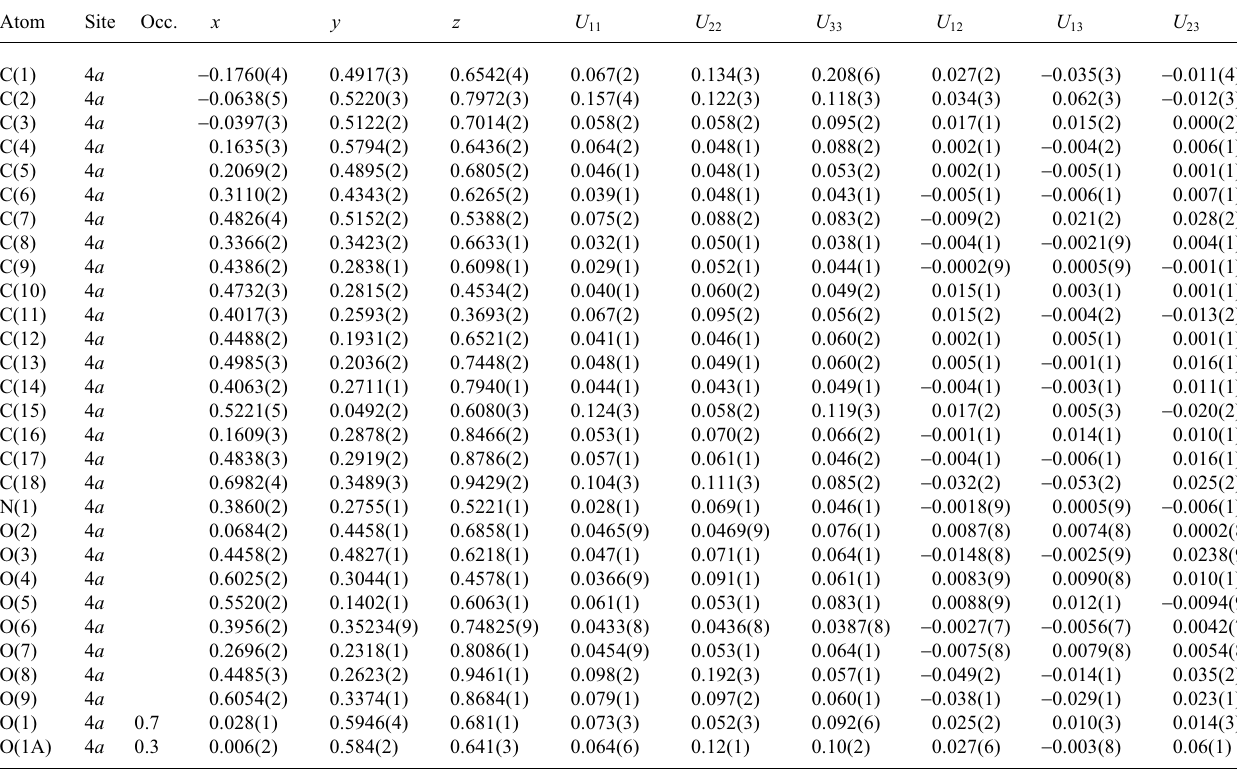
Table 3. Atomic coordinates and displacement parameters (in Å 2 ) .